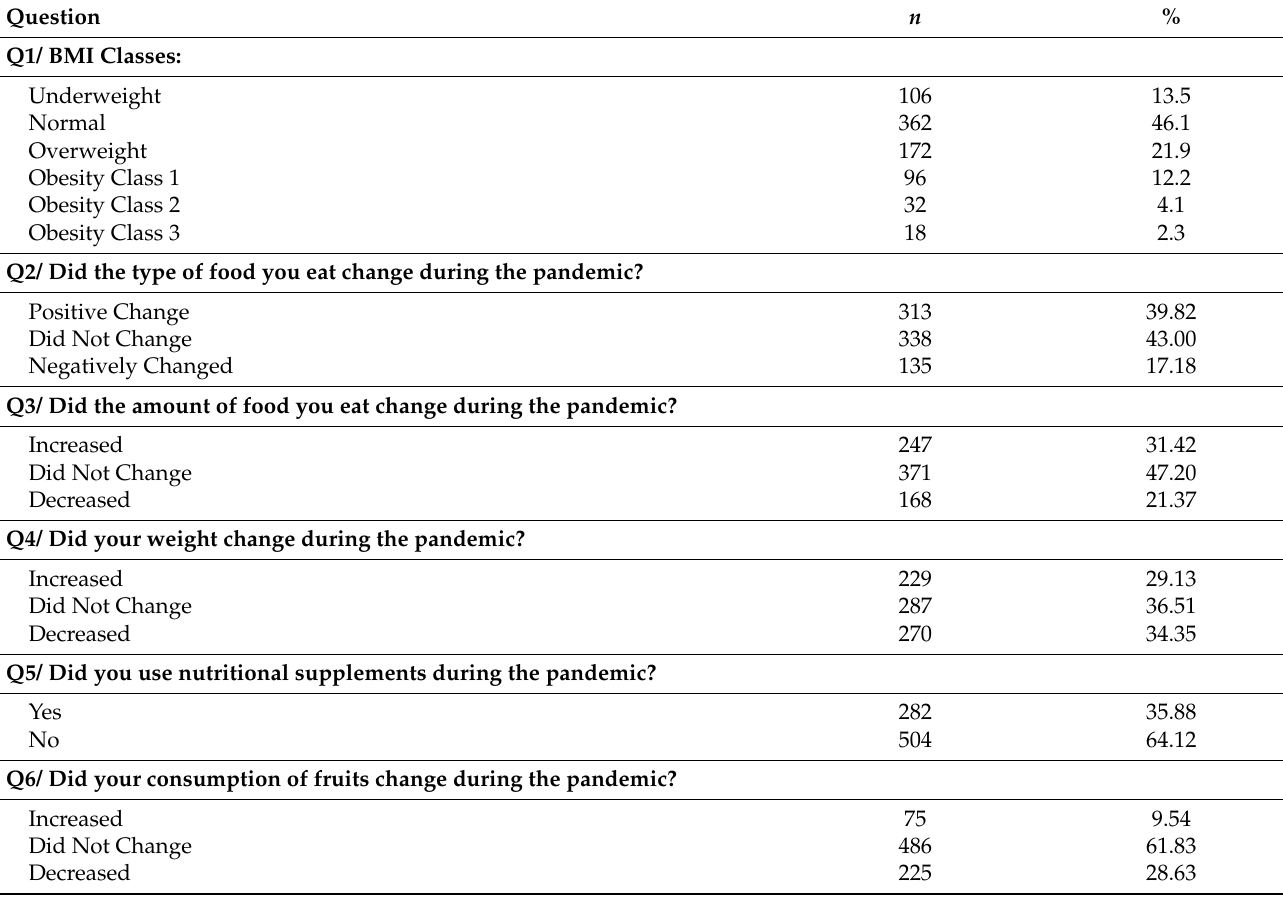
Table 3. Dietary and weight change during COVID-19 pandemic ( n =